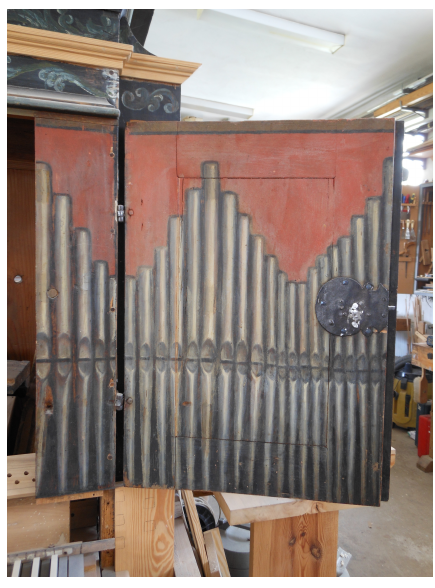
Figure 4. Chest organ right